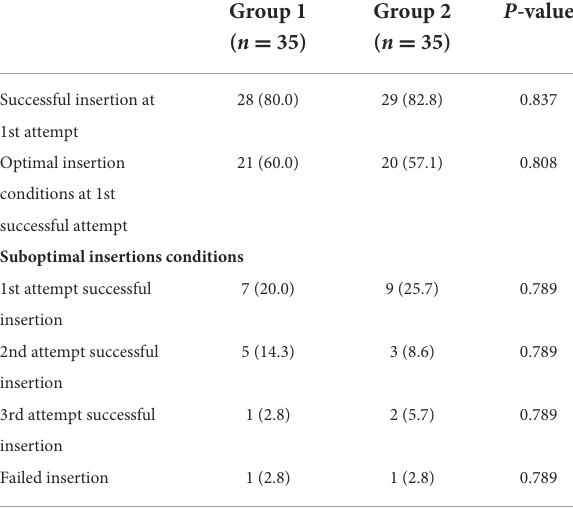
TABLE 2 PLMA insertion attempts and insertion condition.